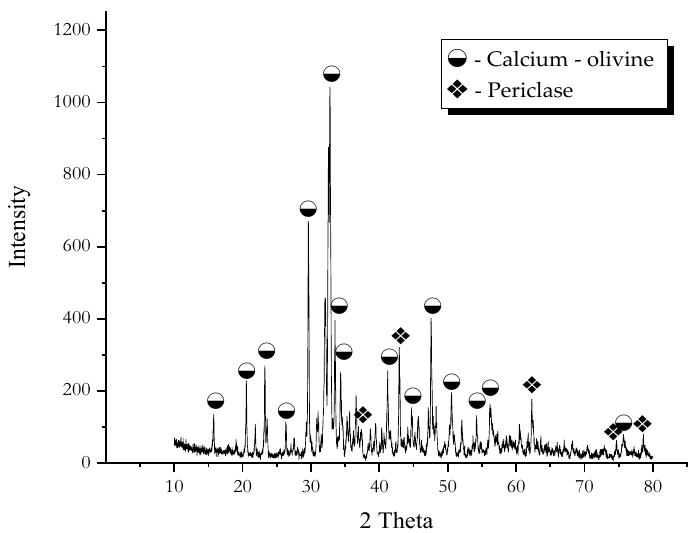
Figure 1. Diffractogram of tailings from the production of metallic